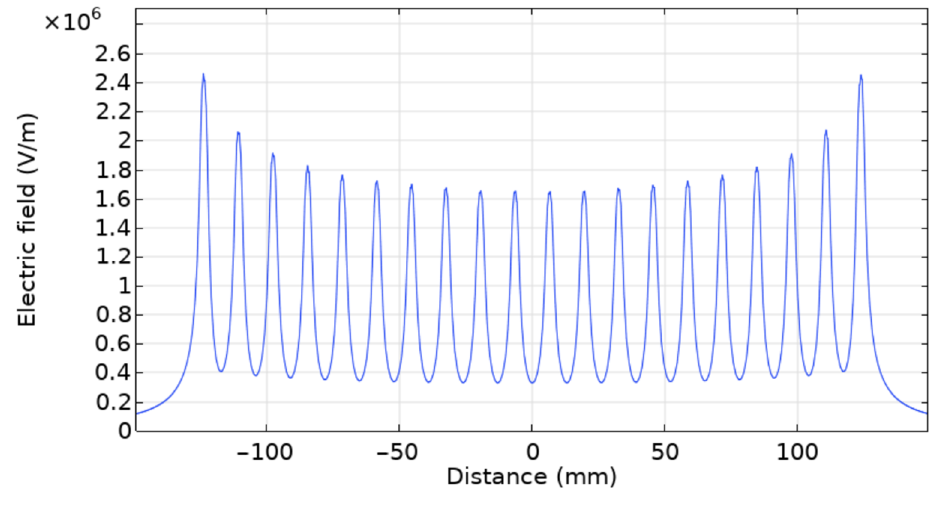
Figure 11. COMSOL electric field simulation initial setup (without auxiliary electrodes), showing electric field 1 mm below the needle the electric field 1 mm below the needle tips.